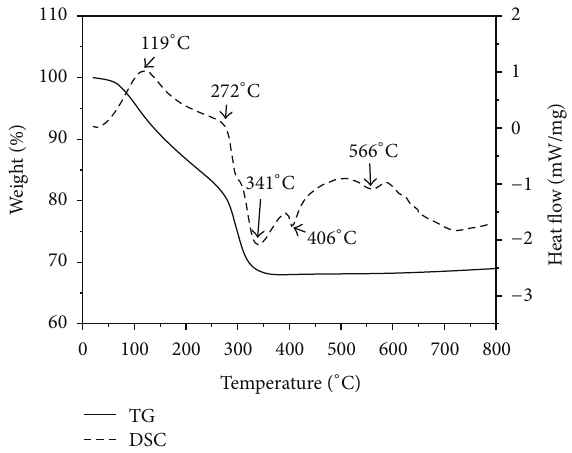
Figure 1: TG-DSC curves of 1.5-Na 2 Ti 6 O 13 /TiO 2 precursor.